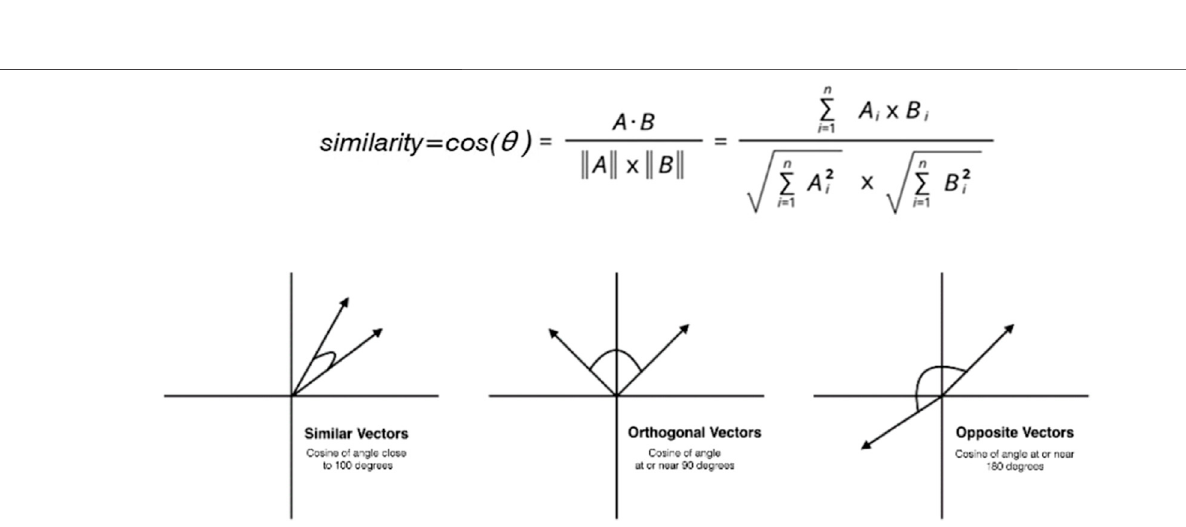
FIGURE 3 | Location of selected houses in Talesh city; Source: